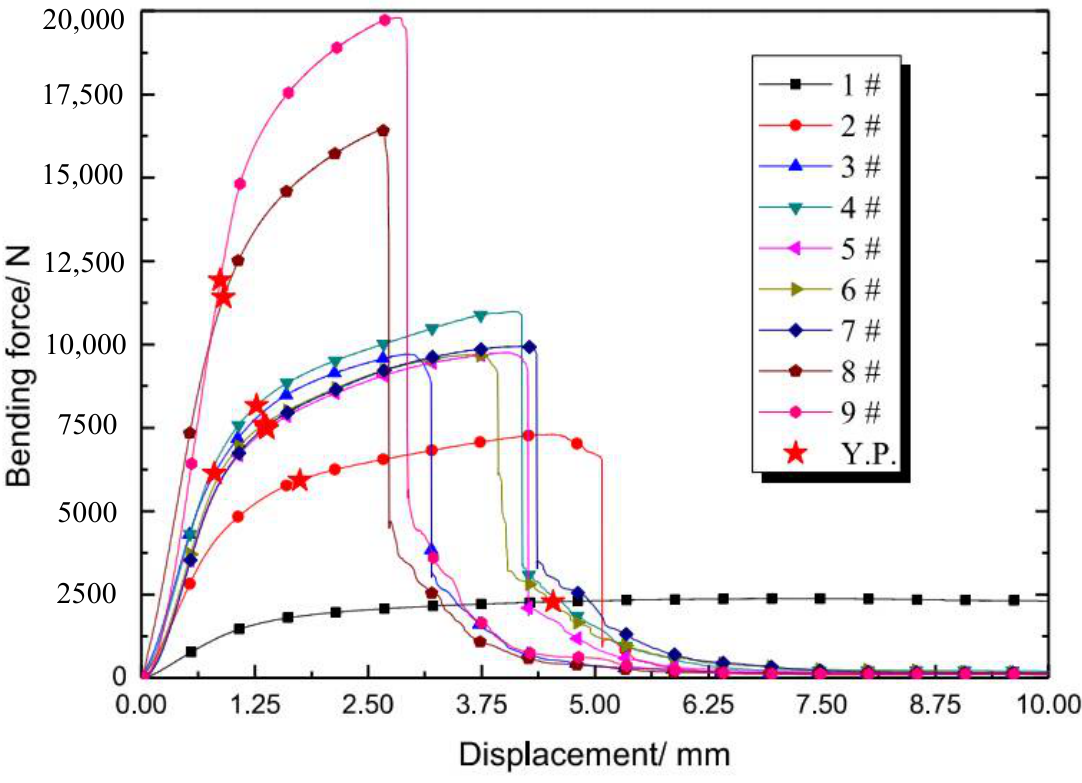
Figure 9. Early characteristic stages of bending. The structural features of each coded sample are indicated in Table 1.